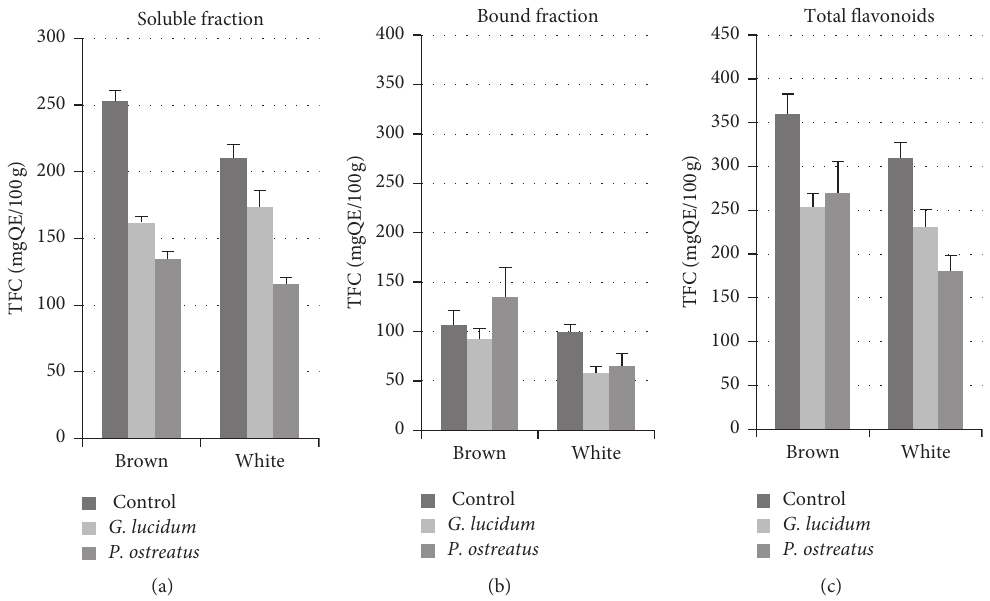
Figure 2: Changes in flavonoid contents of teff grain samples after mushroom mycelium-based solid-state fermentation.